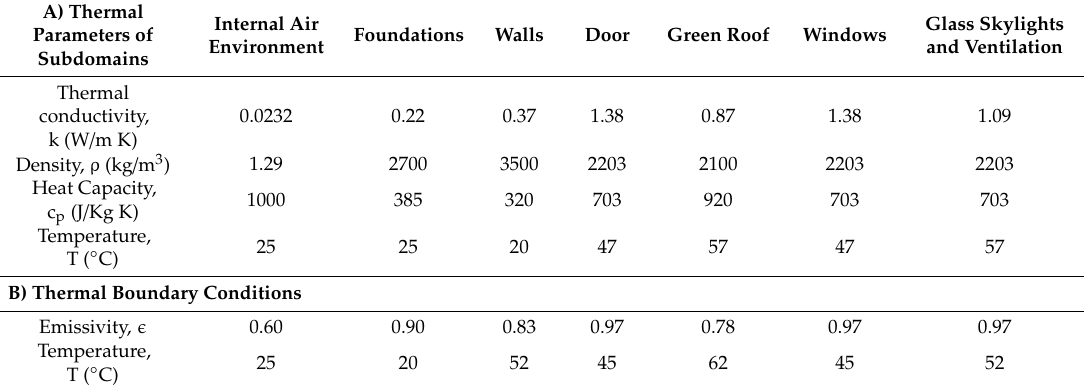
Table1. Parametersusedinthesimulationofthermaltransference. A)Specialconditionsforsub-domain and boundary conditions. B) Structure boundary